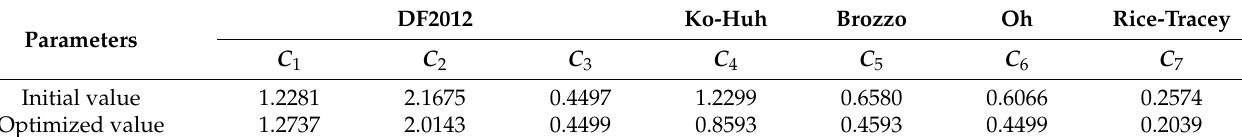
Table 6. The material constants in the ductile fracture criterion.